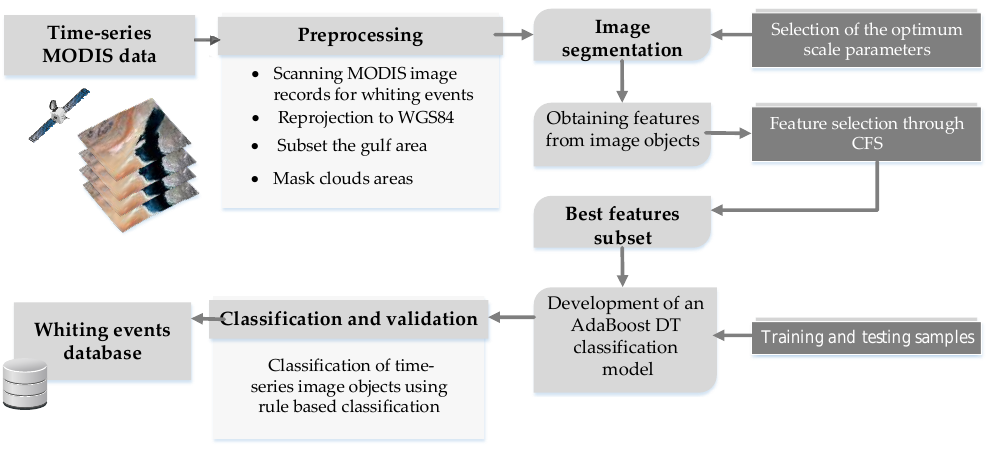
Figure 2. Flowchart of the overall procedure.